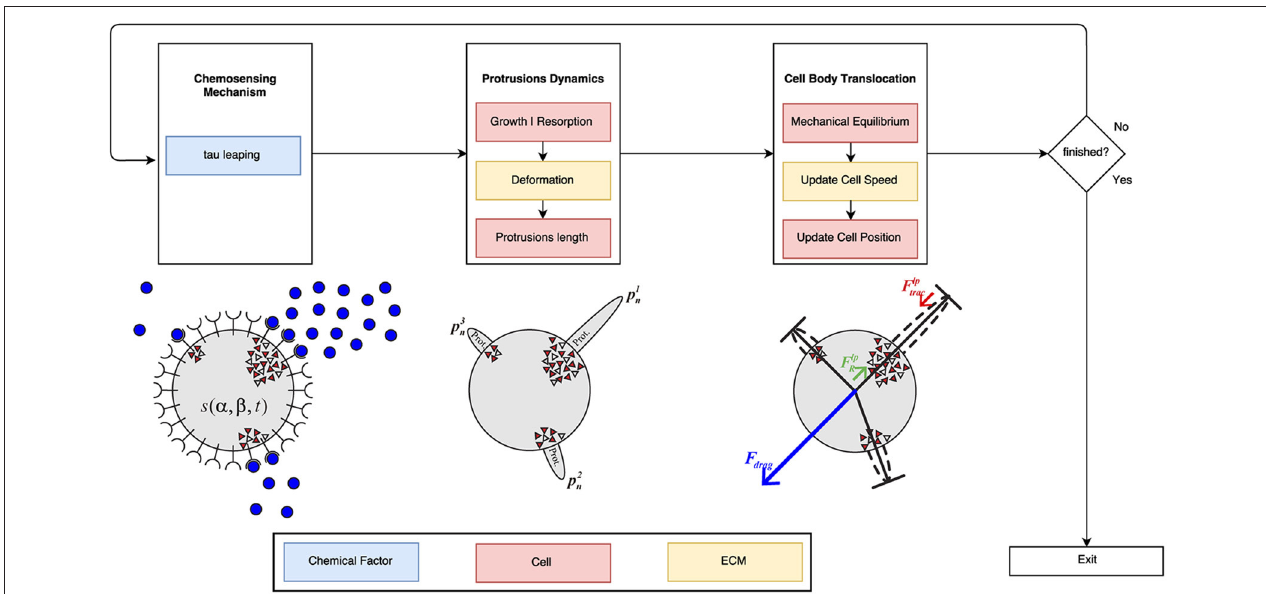
FIGURE 4 | Global algorithm scheme. First, the chemosensing mechanism is simulated using the tau leaping algorithm. In this first stage, the concentration and gradient of the PDGF-BB is the main influence factor. During the second stage of the process, it is taken into account both ECM mechanical properties and cell mechanics in order to simulate protrusions development. Finally, the modeling of the cell body translocation is also influenced by the ECM mechanical properties (in particular, ECM viscosity) as well as cell mechanics. The blue boxes are associated with the chemical factor, the red ones with cell mechanics and the yellow ones with the ECM mechanical properties.